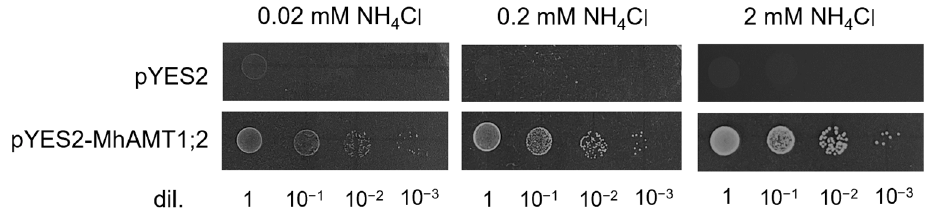
Figure 7. Functional analysis of MhAMT1;2-mediated NH 4+ uptake in yeast. Yeast strains 31019b transformed with pYES2 or pYES2- MhAMT1;2 were grown on YNB medium, supplemented with different concentrations of NH 4 Cl. Final dilutions are indicated by 1, 10 − 1 , 10 − 2 , and 10 − 3 .